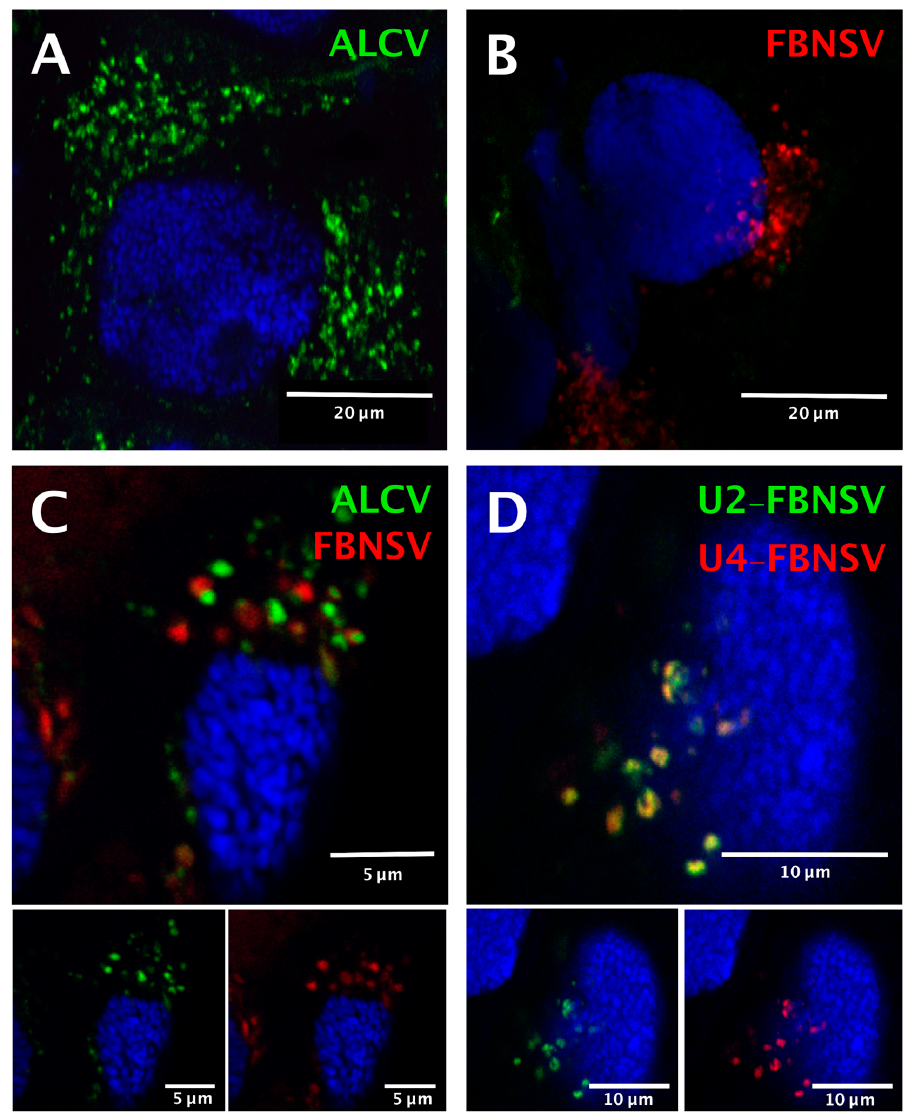
Figure 3. Localization of ALCV and FBNSV DNA in anterior midgut cells of A. craccivora . Co-labeling of ALCV (green) and FBNSV (8 segments probes, red) in aphids fed on plants infected with ALCV alone ( A ), FBNSV alone ( B ), or with both viruses ( C ). Co-labeling of the two FBNSV segments U2 (green) and U4 (red) in aphids fed on plants co-infected by FBNSV and ALCV ( D ). Top panels in C and D are images with merged color channels, and the corresponding split channels are at the bottom left (green) and right (red). Images A and B correspond to maximum intensity projections and images C and D to single optical sections. Cell nuclei are blue-stained with DAPI.